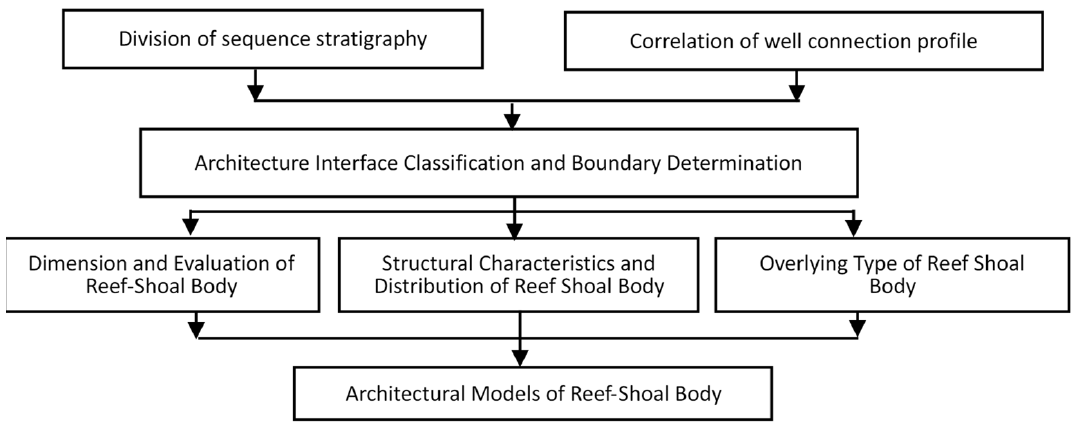
Figure 2. Reef-Shoal Reservoir Architecture Technical flow chart.